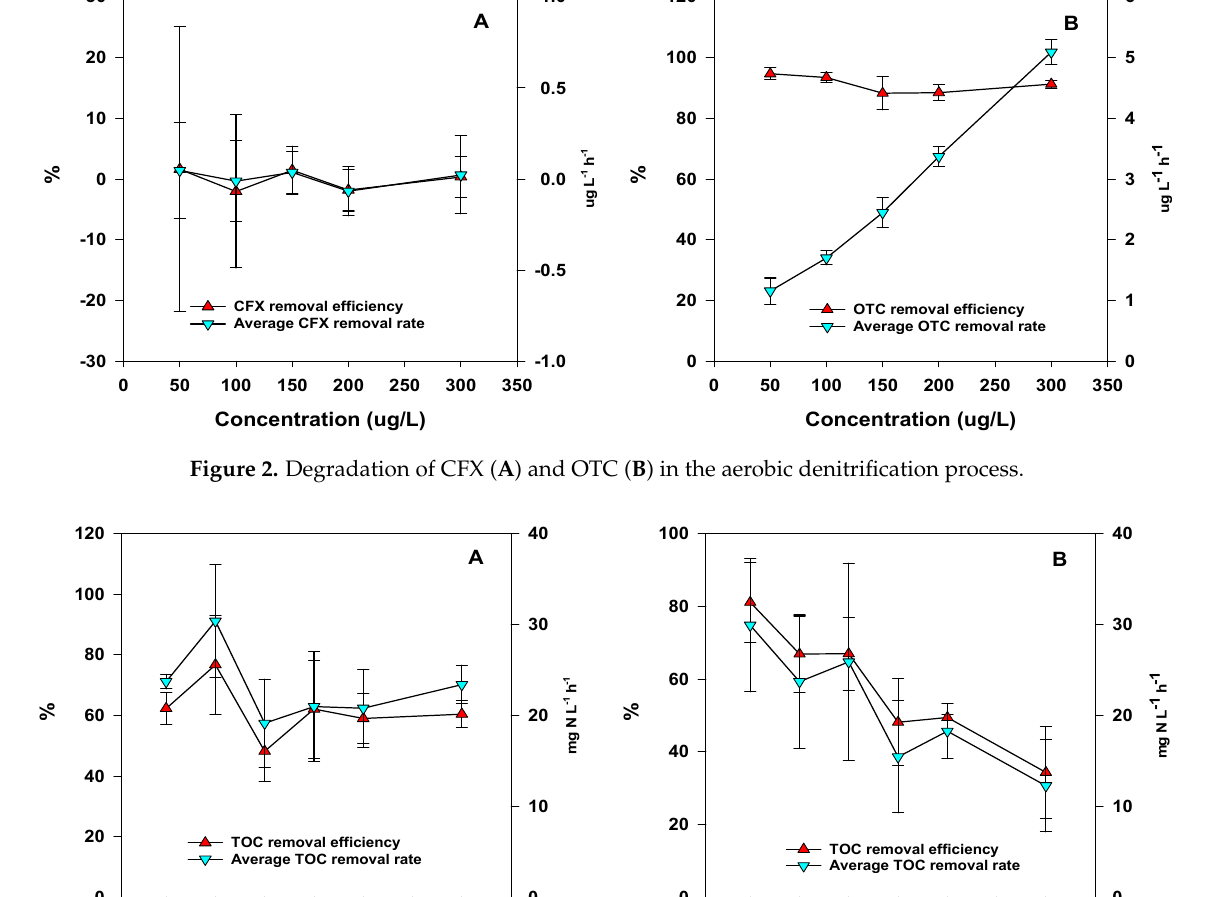
Figure 2. Degradation of CFX ( A ) and OTC ( B ) in the aerobic denitrification process.